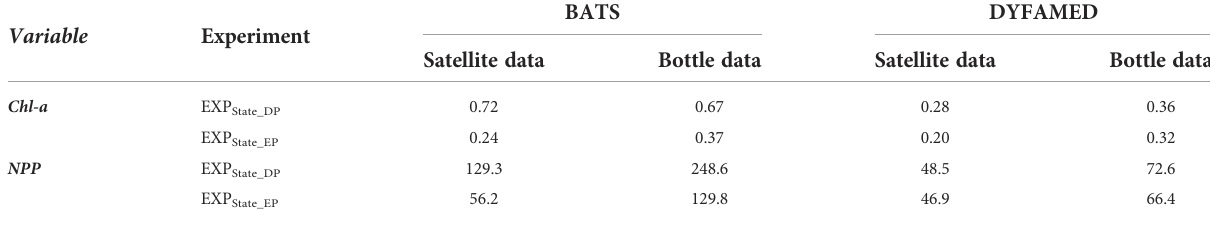
TABLE 2 RMSE of log-transformed surface chl-a concentration from combined assimilation of satellite chl-a and in situ NPP data of EXP State_EP against satellite and bottle data at both stations.